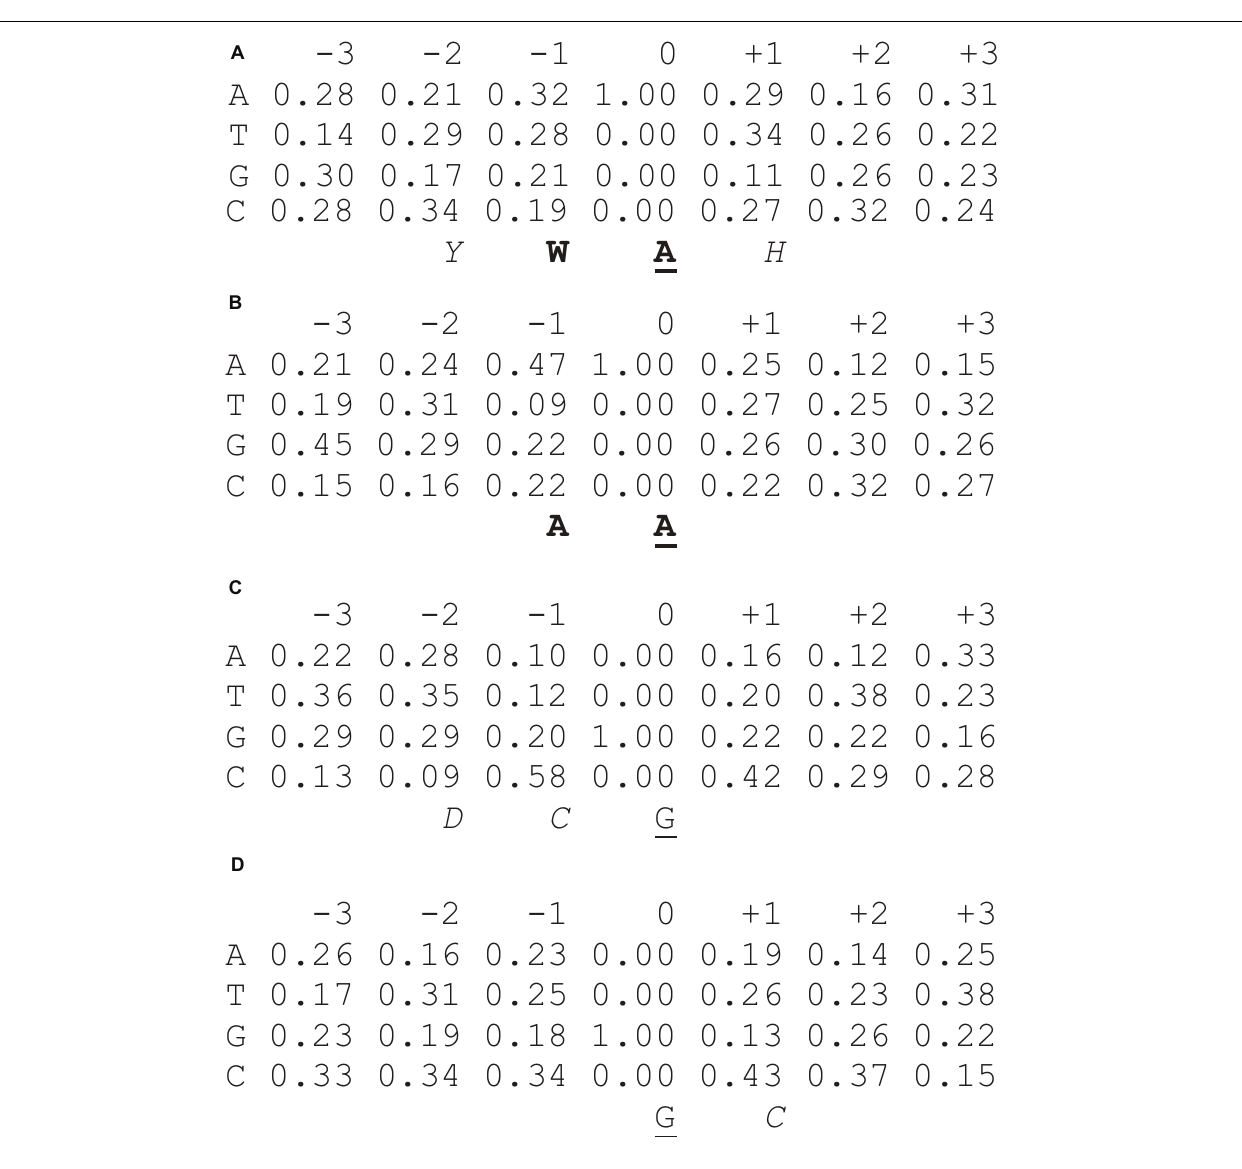
method, as previously described (Rogozin et al., 2018b). The MC test is based on the random sampling from the group 2. In total, 10,000 groups with size S1 have been generated. The fraction of generated groups with mean weights larger or equal to the mean value of the sample 1 is the P